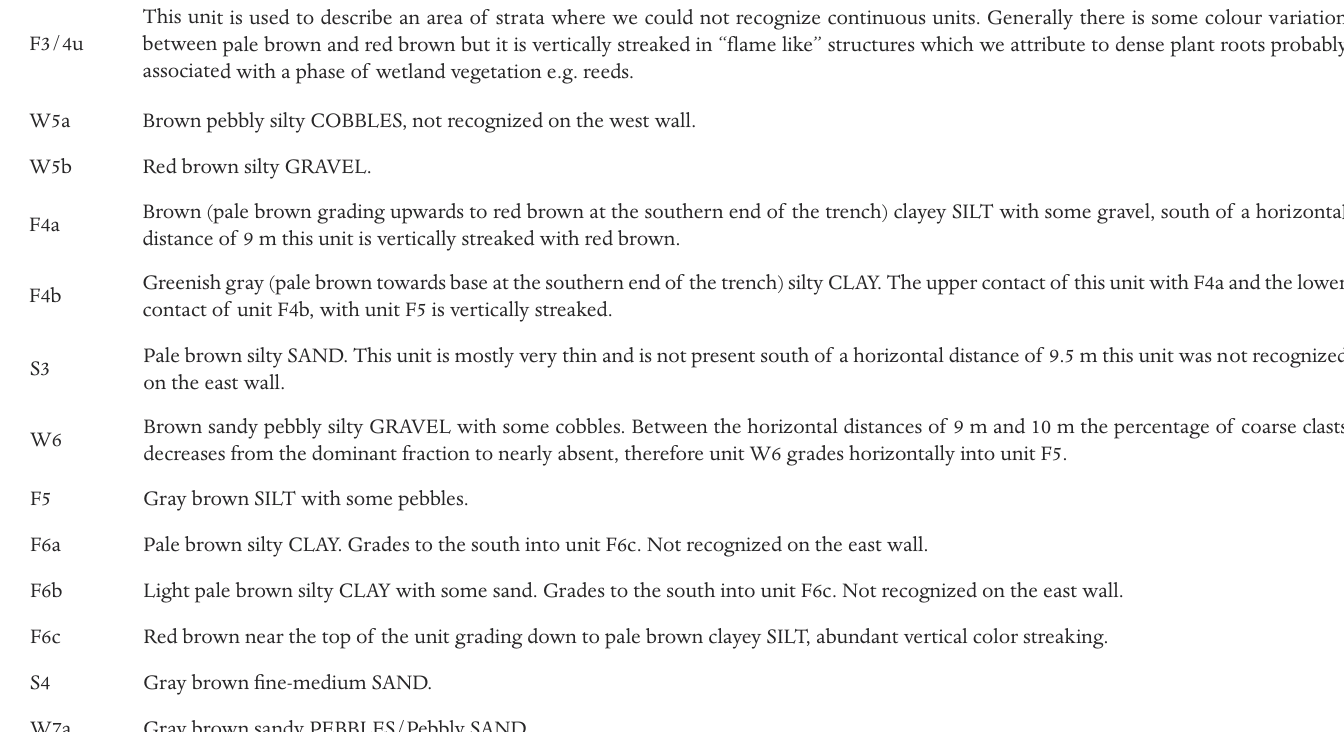
Table A.A-3. (continues on following